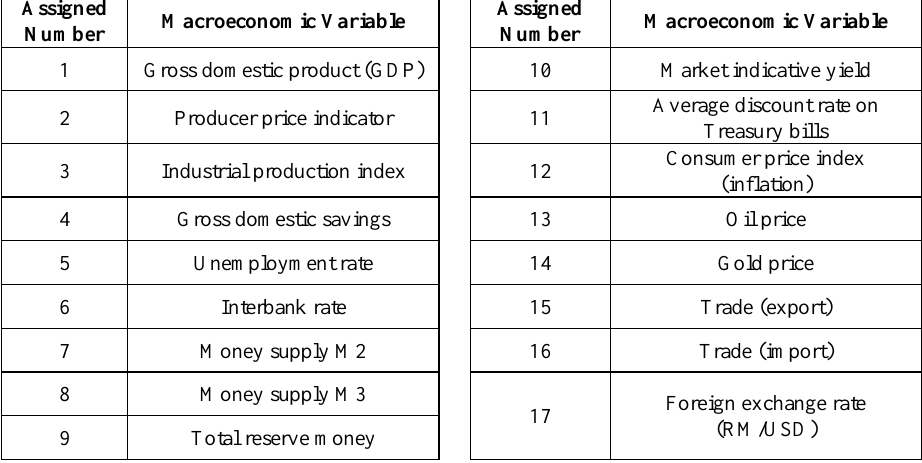
Table 1. Malaysian macroeconomic